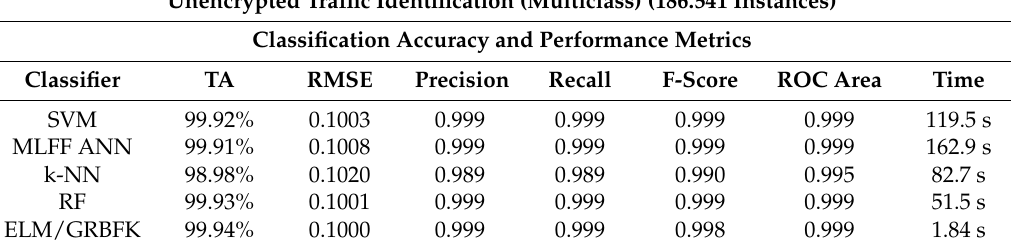
Table 6. Comparison between